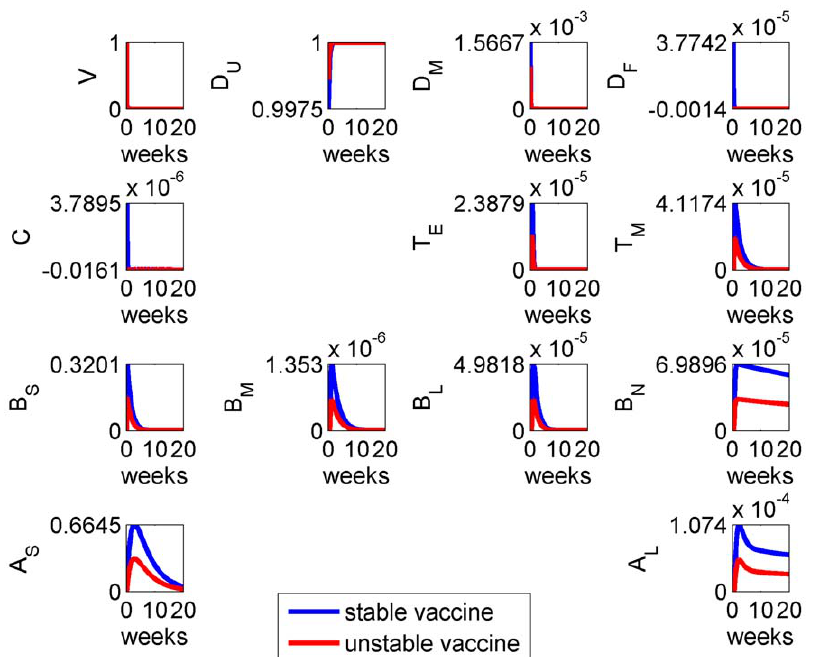
Figure 4. Model results for the system with stable (blue) and unstable (red) vaccine, the latter having a decay rate d V roughly twice that of the former (see Table 2). The benefits of stability are not fully realised until a booster dose is applied (see Figure 5).